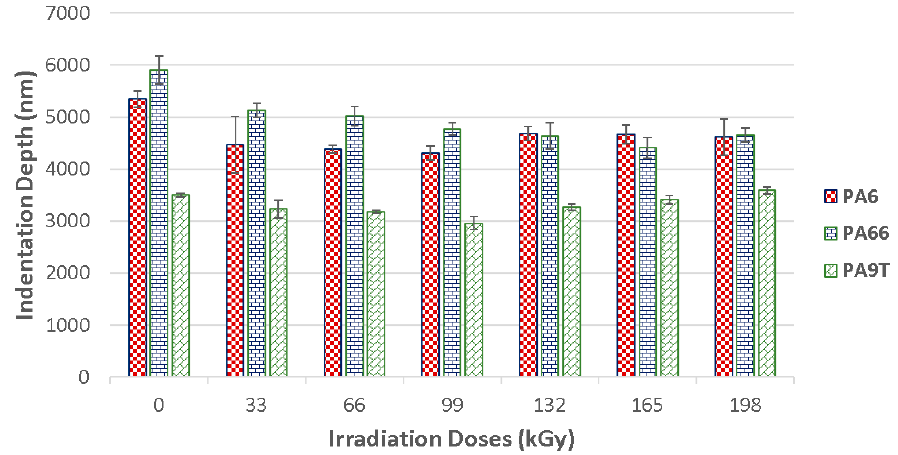
Materials 2020 , 13 , x FOR PEER REVIEW 10 of 17 Figure 6. Indentation depth (h max ) of irradiated PA 6, PA 66 and PA 9T. Figure 6. Indentation depth (h max ) of irradiated PA 6, PA 66 and PA 9T.